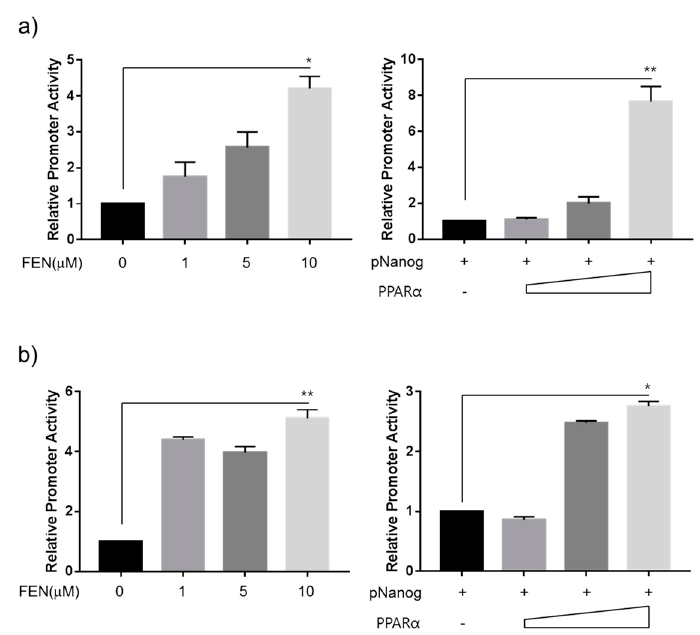
Figure 5. PPAR α activates the Nanog promoter. Transcriptional activation of the Nanog promoter by PPAR α stimulation in ( a ) J1 ESCs and ( b ) 293T cells. J1 ESCs and 293T cells were transfected with the Nanog5P luciferase reporter plasmid and treated with FEN at the indicated concentrations (a and b, left) the next day. Nanog5P (2 µ g) was transfected together with pSG5- PPAR α (0, 1, 2, and 4 µ g, respectively) into J1 ESCs and 293T cells (a and b, right). Firefly luciferase activity was normalized to renilla luciferase activity to correct for transfection efficiencies.